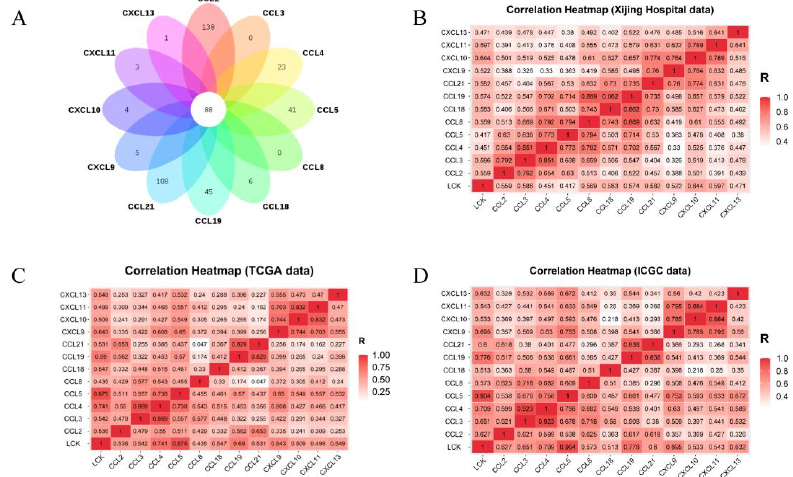
Figure 6. ( A ) Venn diagram of 12 chemokine-related molecules predicted with LinkedOmics. Spear- Figure 6: (A) Venn diagram of 12 chemokine-related molecules predicted with 310 man correlation heatmaps of LCK and chemokine expression from ( B ) Xijing Hospital data; ( C ) TCGA data and ( D ) ICGC LinkedOmics. Spearman correlation heatmaps of LCK and chemokine expression from 311 (B) Xijing Hospital data; (C) TCGA data and (D) ICGC data. 312